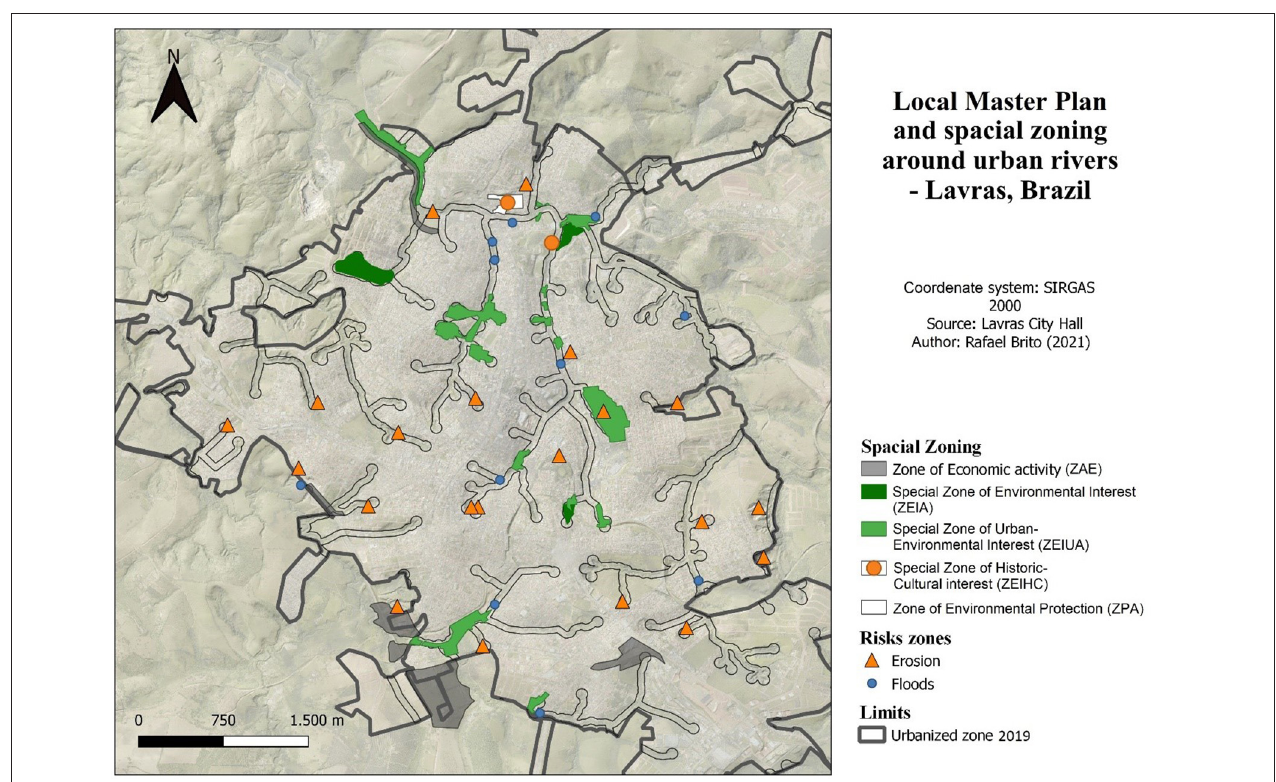
FIGURE 11 | Urban zoning proposed in the area under study according to the Local Master Plan. Source: Sousa R. B. et al. (2021).